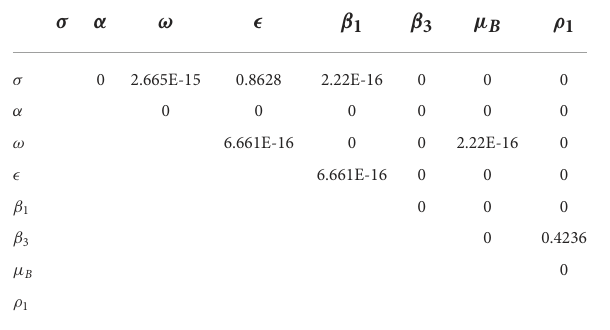
TABLE 4 Pairwise PRCC comparison (unadjusted P -values).